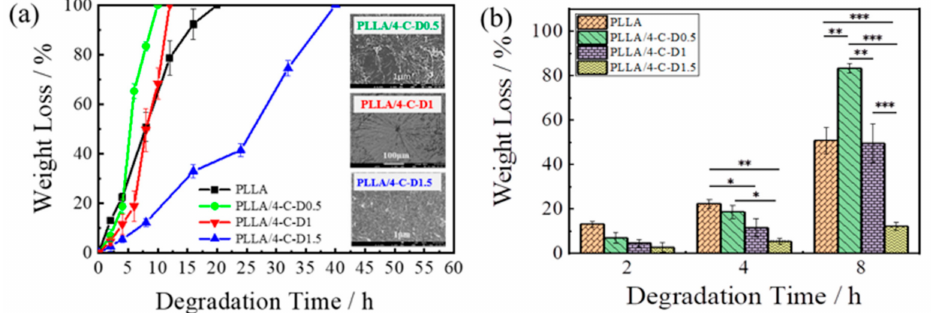
Figure 6. ( a ) Weight loss and degradation morphologies of the PLLA / 4-C-D blend films with di ff erent PDLA block lengths. ( b ) Weight loss of PLLA / 4-C-D blend films after degradation for 2, 4 and 8 h (* p < 0.05, ** p < 0.01, *** p < 0.001, n =